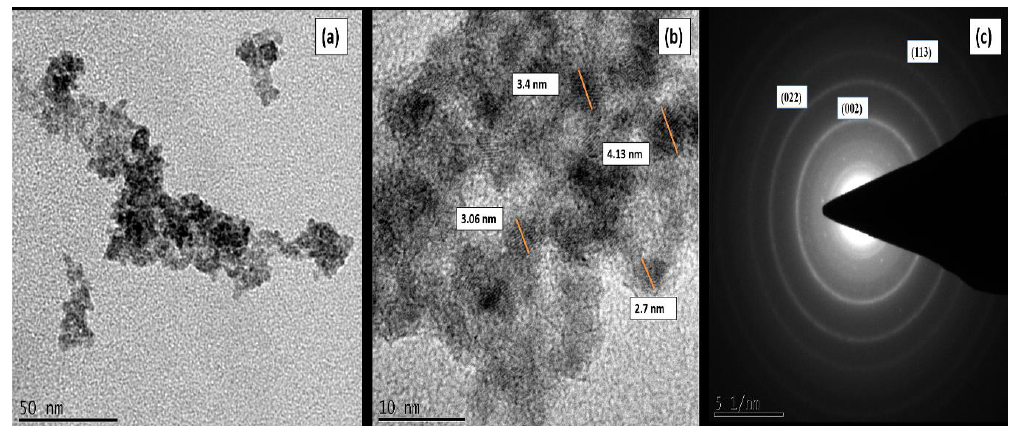
Figure 2. ( a , b ) HR-TEM of MgO 2. ( c ) SAED of MgO 2 .